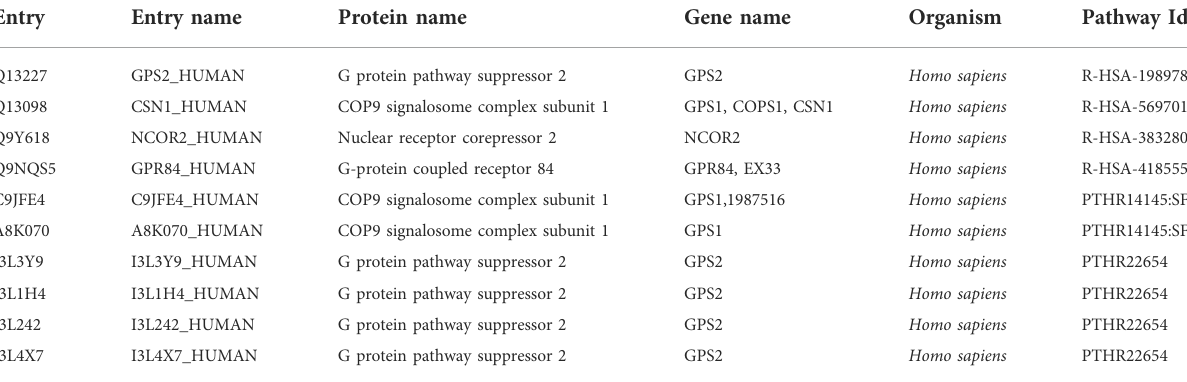
TABLE 7 Providing ubiquitin protein-pathway association